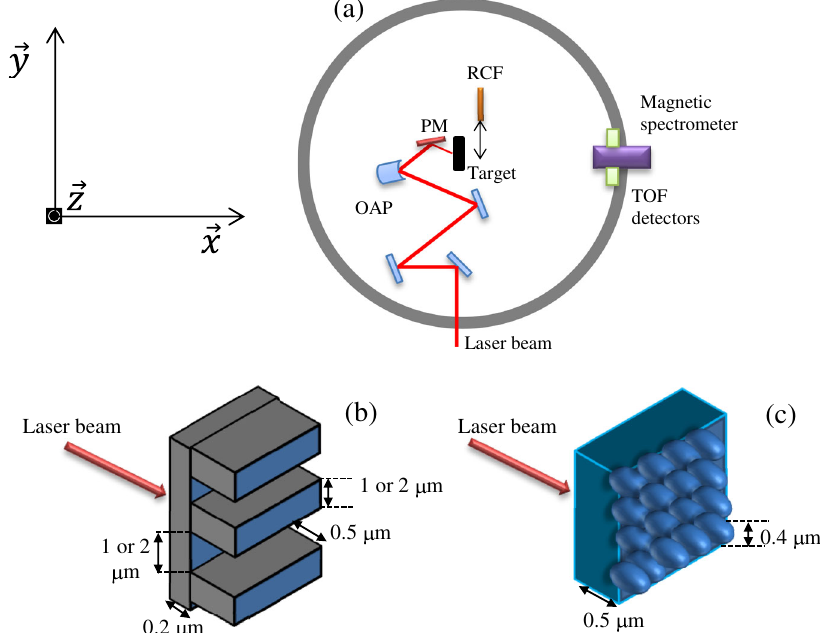
FIG. 1. Top view of the experimental setup (a), sketch showing the plastic target covered with nanospheres (b), and side view of the grating targets (c) used in the experiment. Here ⃗ x is the axis normal to the target surface, ⃗ y is the direction perpendicular to the orientation of grating ridges and ⃗ z is the direction parallel to the orientation of horizontal grating